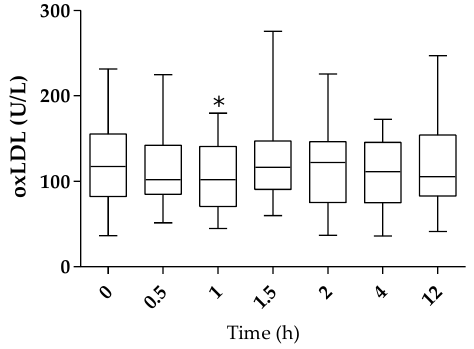
Figure 1. oxLDL values before and after HT administration through food supplements (n = 25). The graph shows the median oxLDL concentration (U/L) in plasma, maximum and minimum values, 25% and 75% percentiles. *: significantly different from baseline with p < 0.05.